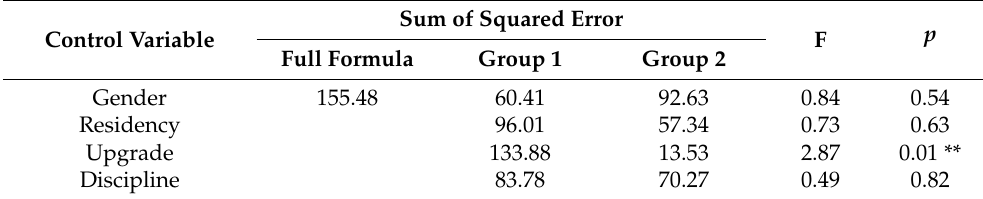
Table 5. Chow Test for the influence of the grouped control variable on the regression